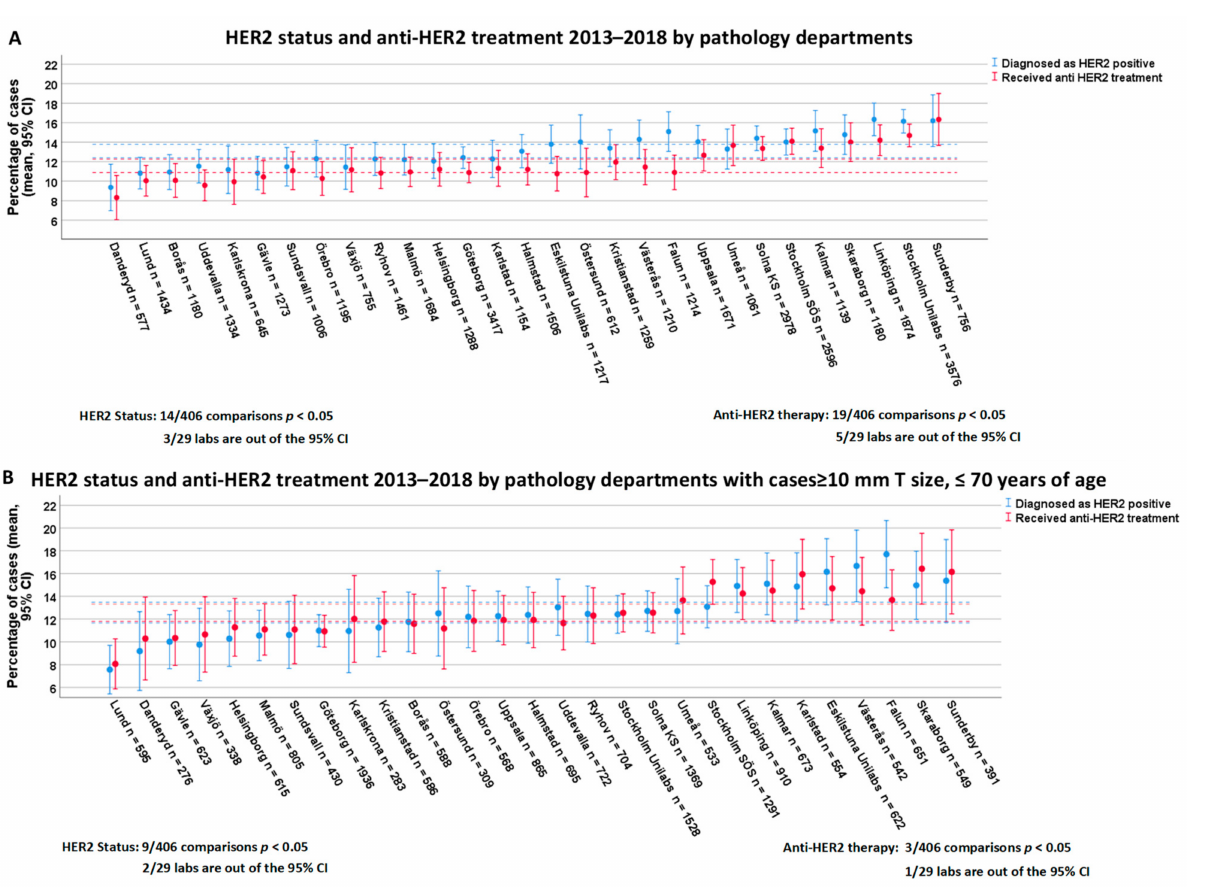
Figure 3. HER2 status and anti-HER2 treatment between 2013 and 2018 by pathology department. Dashed lines represent the CI for overall positivity (blue) and overall treatment rate (red). ( A ) includes all the patients while ( B ) shows results with cases ≥ 10 mm T size, ≤ 70 years of